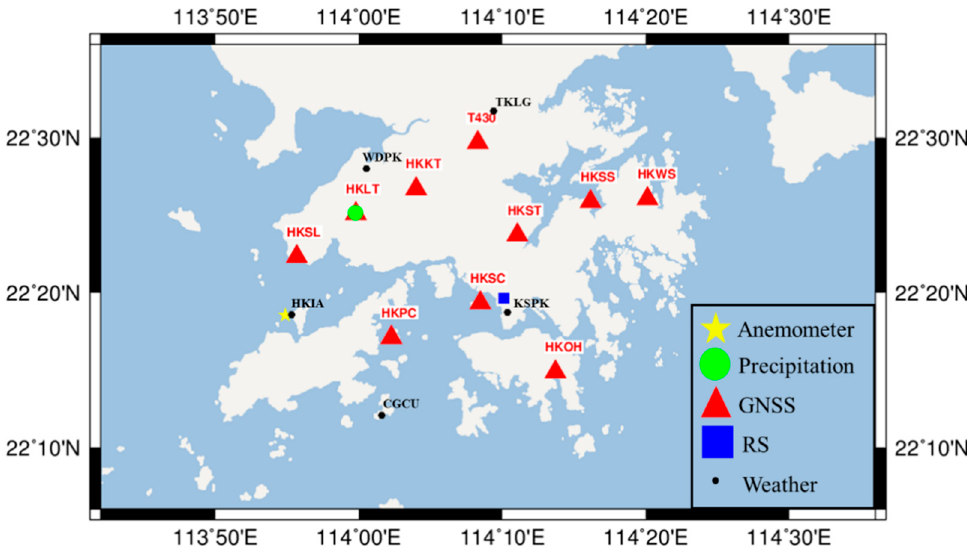
Figure 1. Location of the Hong Kong continuously operating reference stations (CORS) equipped with meteorological observing equipment (red triangles), radiosonde (RS) station (blue square), precipitation station (green circle), anemometer station (yellow star), and automatic weather stations (black dots).